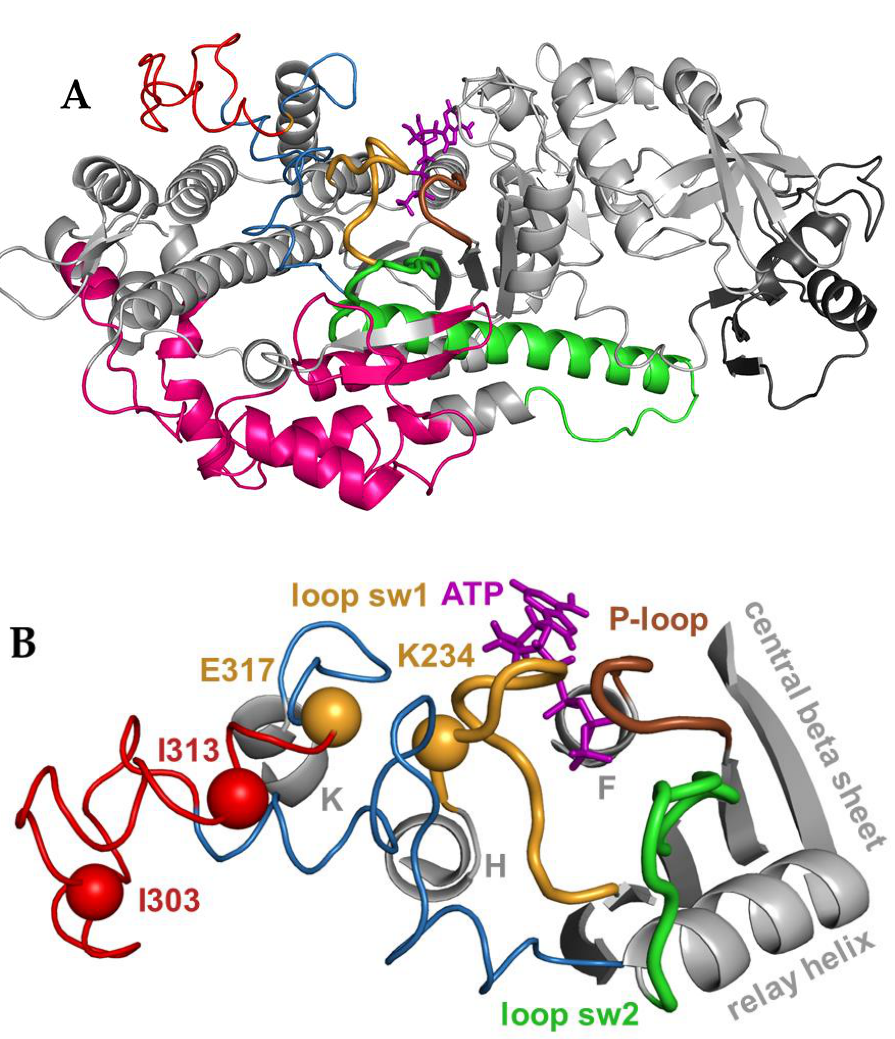
Figure 1. ( A ) Myosin head, location of the active site and loop S291-E317. Bulk colored regions and elements, pink, the actin binding interface, green, the relay helix and loop, dark grey, the converter domain. Colored loops show the myosin active site. ( B ) Myosin active site, formed by P-loop (brown), loop switch 1 (orange), and loop switch 2 (green). Beta iso- form of human cardiac myosin, 4db1.pdb. ATP bound to the active site is colored purple. Loop L268-D324 is colored blue, and the loop S291-E317 part of it, discussed in the paper, is colored red. Residues I303 and I313 are shown as red spheres. Residues E317 and K234 are shown as orange spheres. K, H, F, and relay are helices connected to the C-termini of loops L268-D324, switch 1, P, and switch 2, respectively. N-termini of all mentioned loops are connected to strands 4 – 7 of the central beta sheet. In this work, we replaced residues I303 and I313 with valines, as they are in alpha isoform. According to the computer simulations, residues E317 and K234 form salt bridge in alpha isoform (populated 35.2% during the cal- culated molecular dynamics trajectory, not populated in beta isoform). Loop L268-D324 is shown without helical content to simplify the